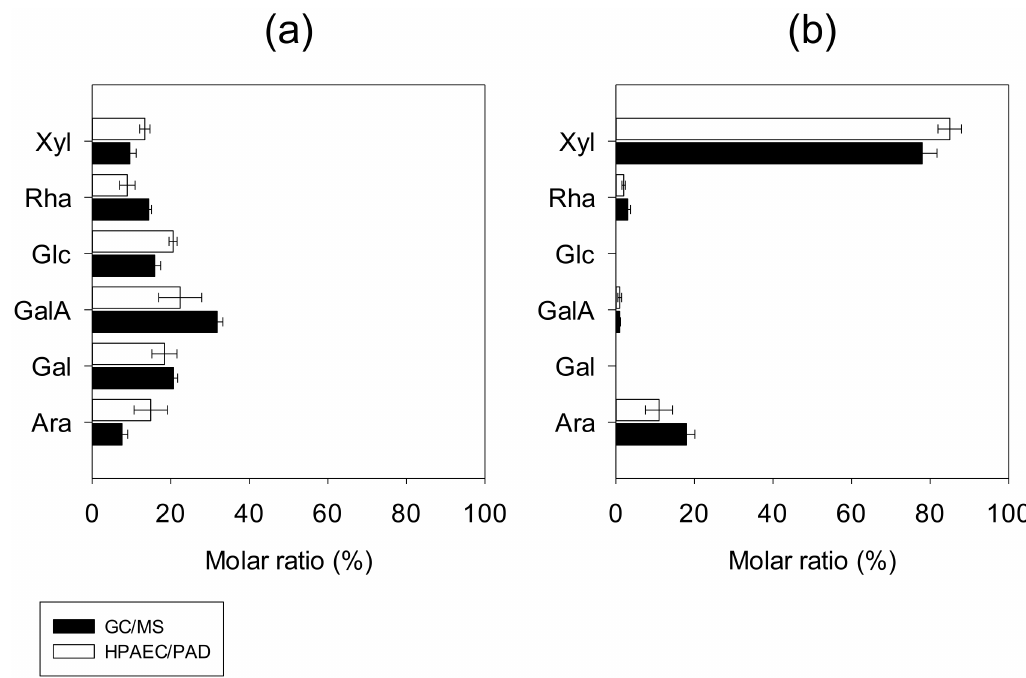
Figure 3. Monosaccharide compositions of ( a ) L-PSPC (leaves) and ( b ) S-PCPC (seeds). White and black bars, respectively correspond to the results obtained from HPAEC-PAD or GC/MS-EI